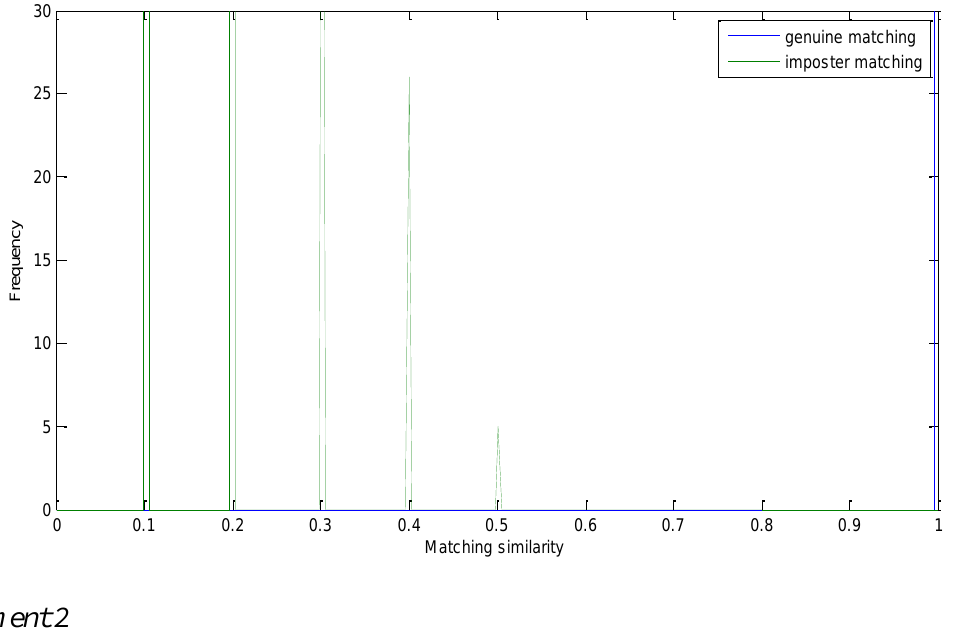
Figure 8. Distribution of matching similarity of the proposed method.